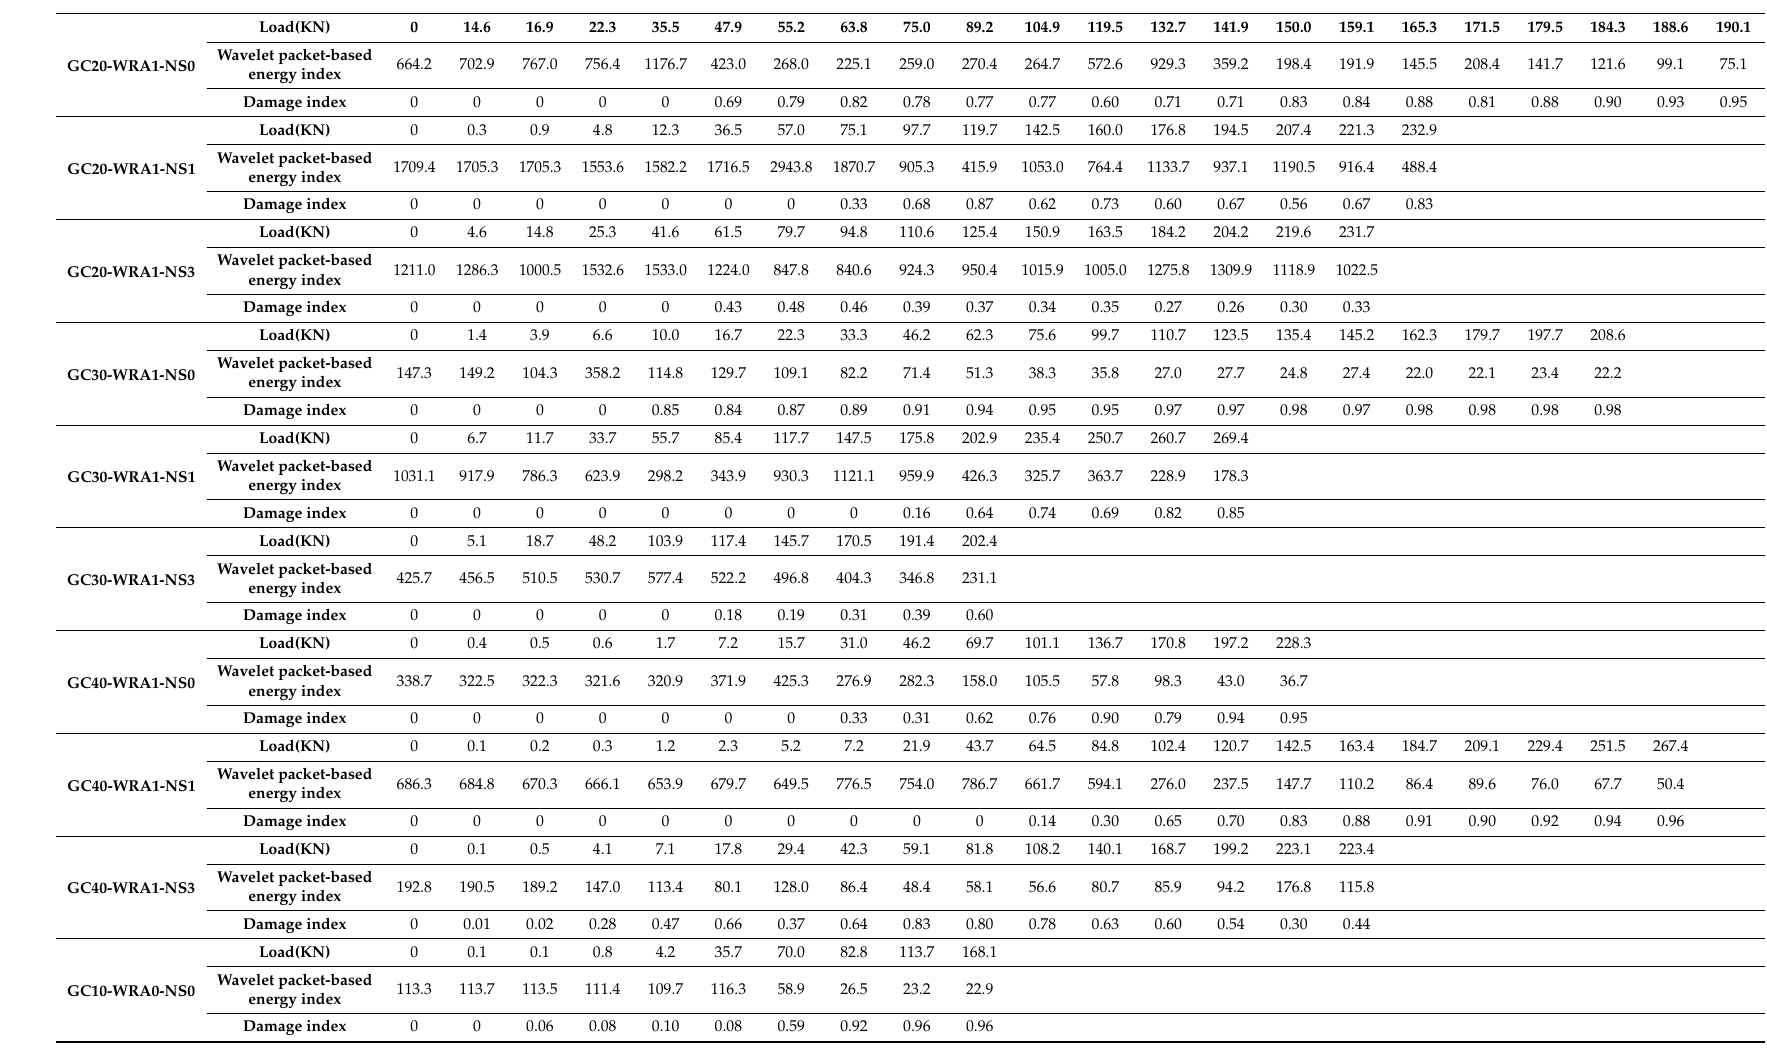
Table 2. Specimen loading and data